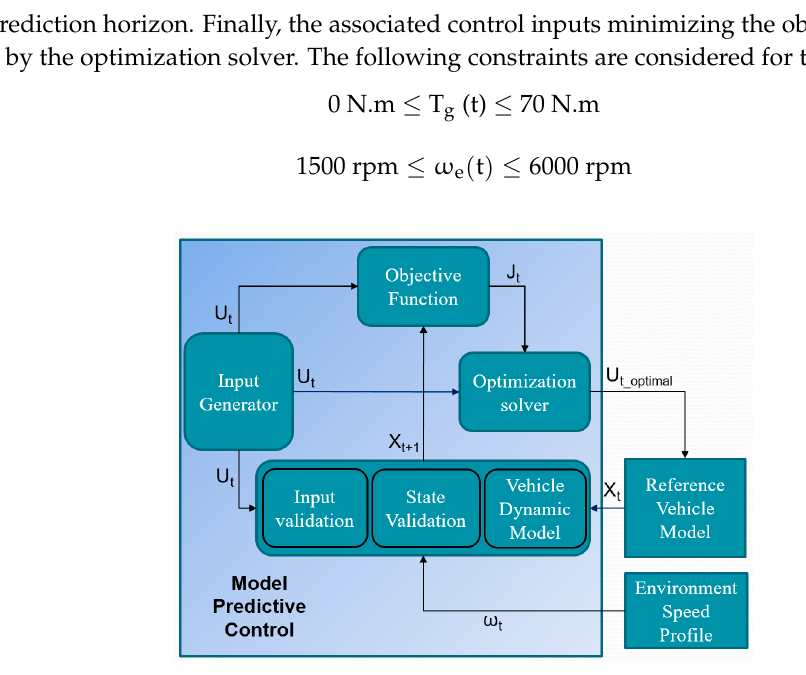
Figure 3. Model predictive control based power management system.